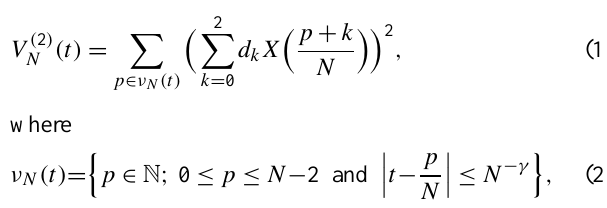
Fig. 1. An mBm with linear h function.